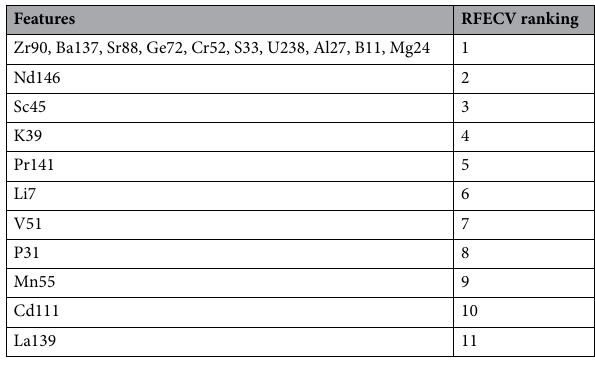
Table 3. Table of the top 20 features